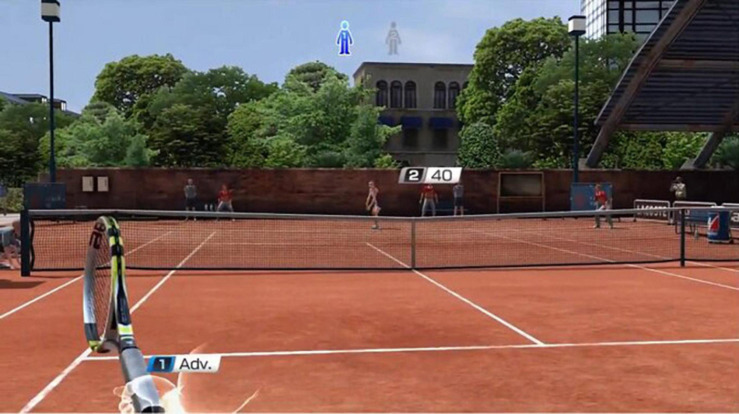
Exergame interface screenshot.